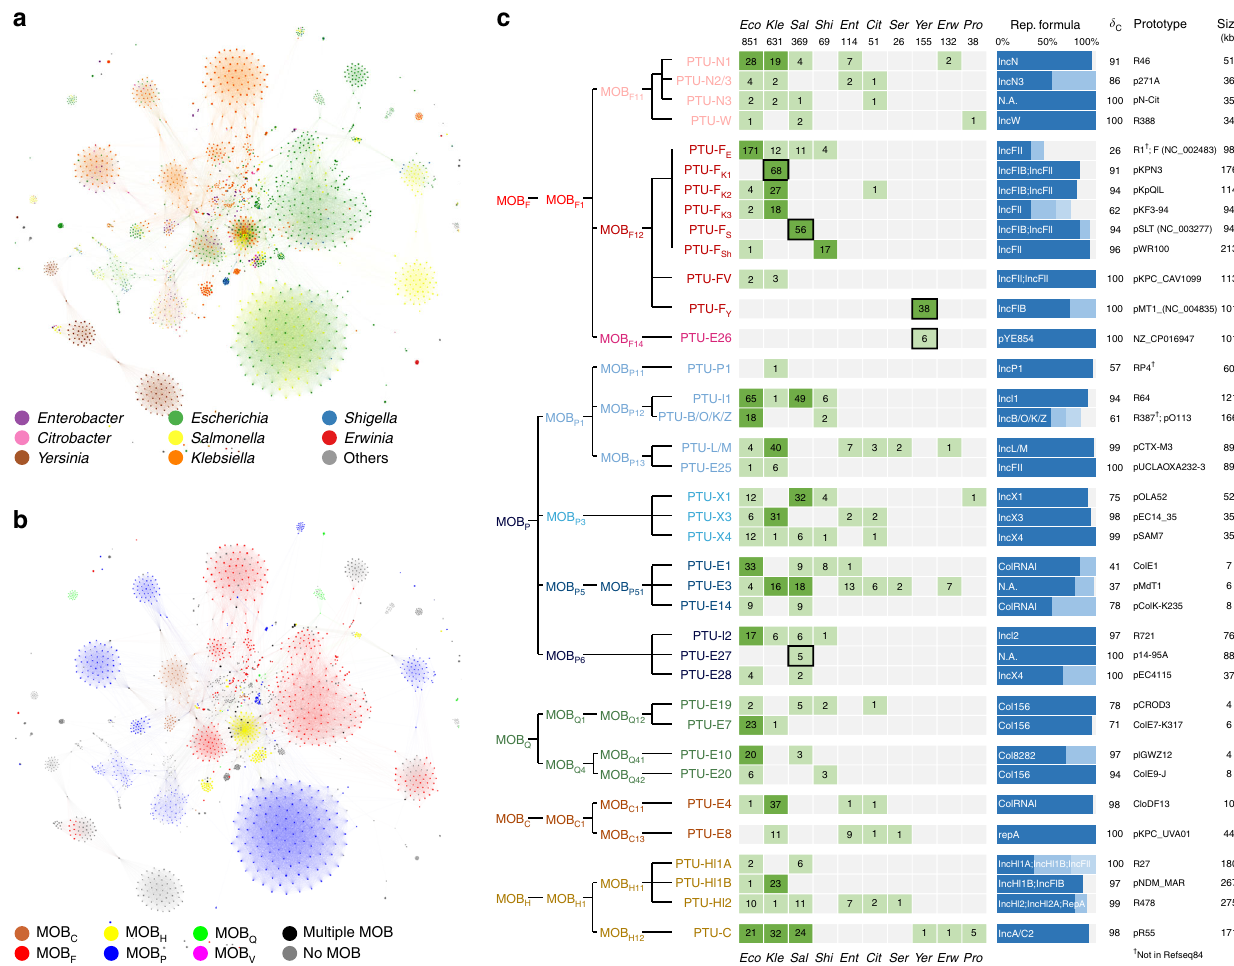
Fig. 4 Conjugative and mobilizable PTUs of the order Enterobacterales . The fi gure represents an integrative view of the PID + SBM methods. a , b ANI network of the Enterobacterales plasmidome, with plasmids colored according to their cognate host ( a ) or the MOB type of each plasmid ( b ). Source data are provided as a Source Data fi le. c A list of the most representative mobilizable and conjugative PTUs from Enterobacterales , according to their MOB type. Columns on the left indicate the MOB type and name of the PTU. Numbers in the boxes indicate the number of plasmids isolated from the different genera shown in the fi gure. Dark green squares indicate high plasmid prevalence, with >15 different plasmids retrieved from that genus. Boxes correspond, respectively, to Escherichia ( Eco ), Klebsiella ( Kle ), Salmonella ( Sal ), Shigella ( Shi ), Citrobacter ( Cit ), Serratia ( Ser ), Yersinia ( Yer ), Erwinia ( Erw ), and Proteus/ Provide ncia ( Pro ). The number below each taxon represents the total number of plasmids from that taxon present in the database. Boxes squared with a black margin represent PTUs exclusively present in that particular host. The blue bar on the right indicates the most prevalent replicon structure, as determined by PlasmidFinder. The rightmost two columns of the fi gure represent, respectively, the intracluster density, and a prototype plasmid from the